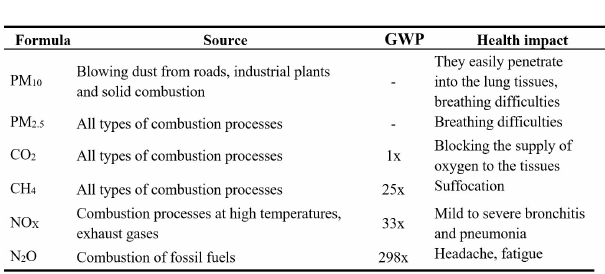
Table 3. Evaluation of boilers according to the Ecodesign system for manually operated